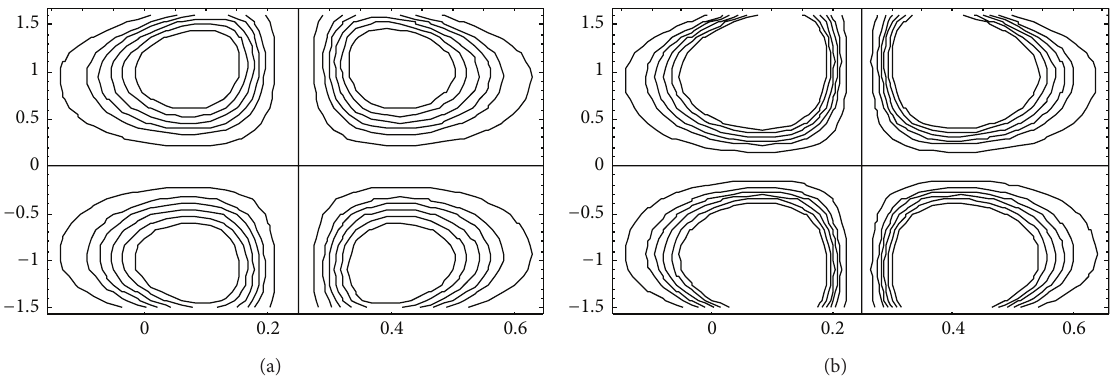
Figure 6: Streamlines when 𝛽 = 0.05 , 𝐸 2 = 0.1 , 𝐸 3 = 0.1 , 𝜀 = 0.1 , 𝛿 = 0.01 , 𝑡 = 0.0 , 𝑅 = 0.01 , 𝑀 = 1 , 𝜆 1 = 0.1 , and 𝜆 2 = 0.05 . (a) 𝐸 1 = 0.1 and (b) 𝐸 1 = 0.3